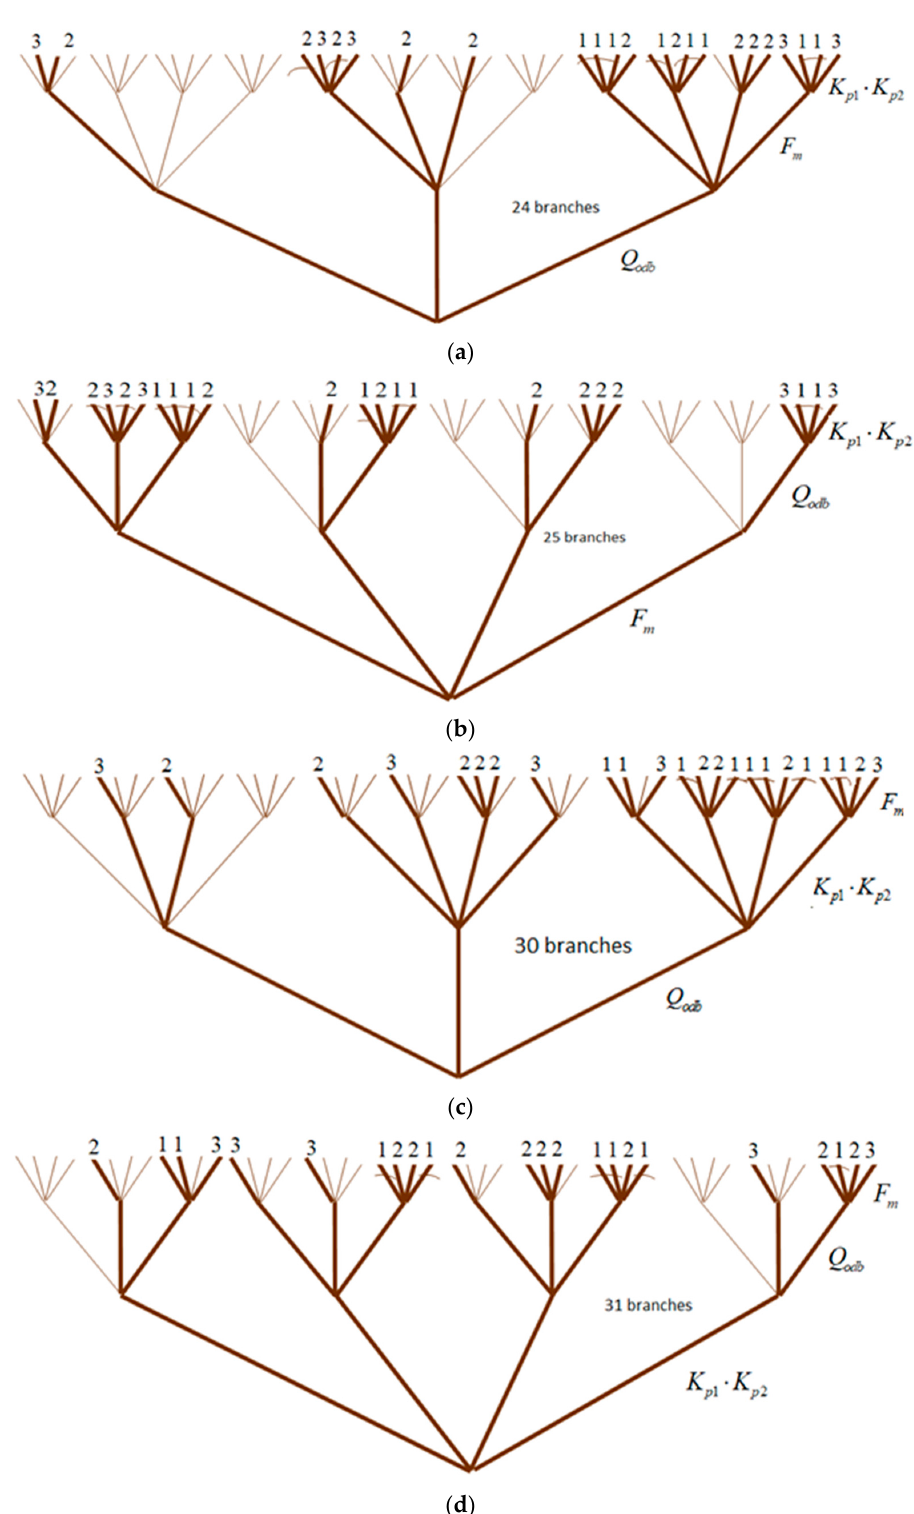
Figure 14. Multi-valued logical tree of the K p1 ·K p2 , Q rz , and F m parameters with ( a ) 24 branches, ( b ) 25 branches, ( c ) 30 branches, and ( d ) 31 branches. 1, 2, 3—The values of the weighting factors w i .